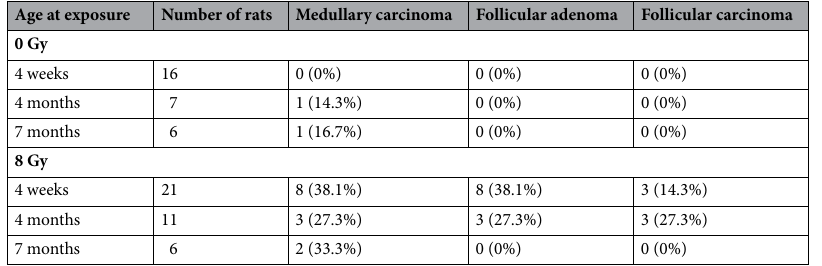
Table 2. Differential incidence of various thyroid tumors types in irradiated and non-irradiated rats.